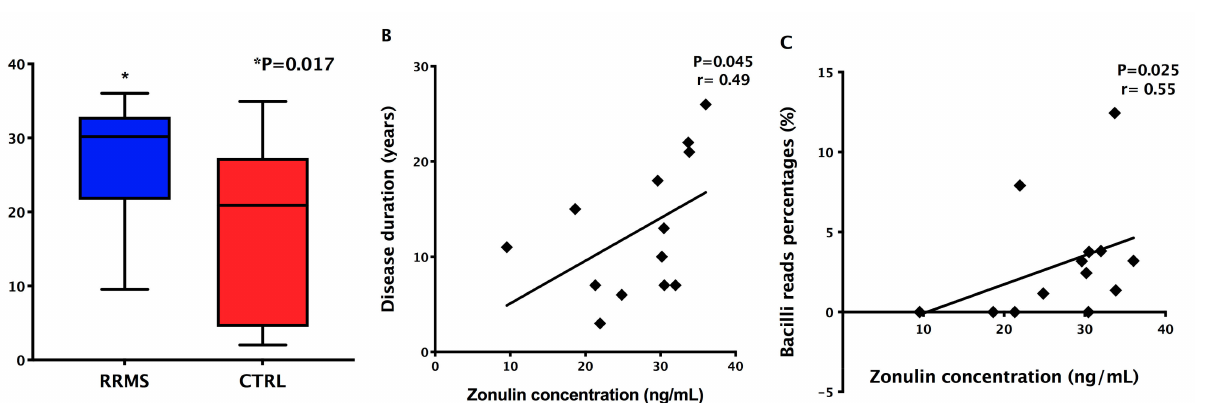
Figure 6. Zonulin concentrations and correlations with clinical data and gut microbiota. ( A ) Serum zonulin concentrations in RRMS patients and controls (CTRL); ( B ) Positive correlation between zonulin concentrations and disease duration; ( C ) Positive correlation between zonulin concentrations and relative abundance of Bacilli class